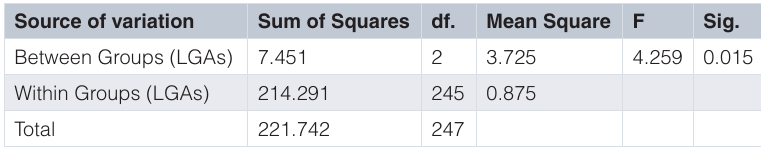
Table 9. Agricultural Extension Services and Location of Respondents.